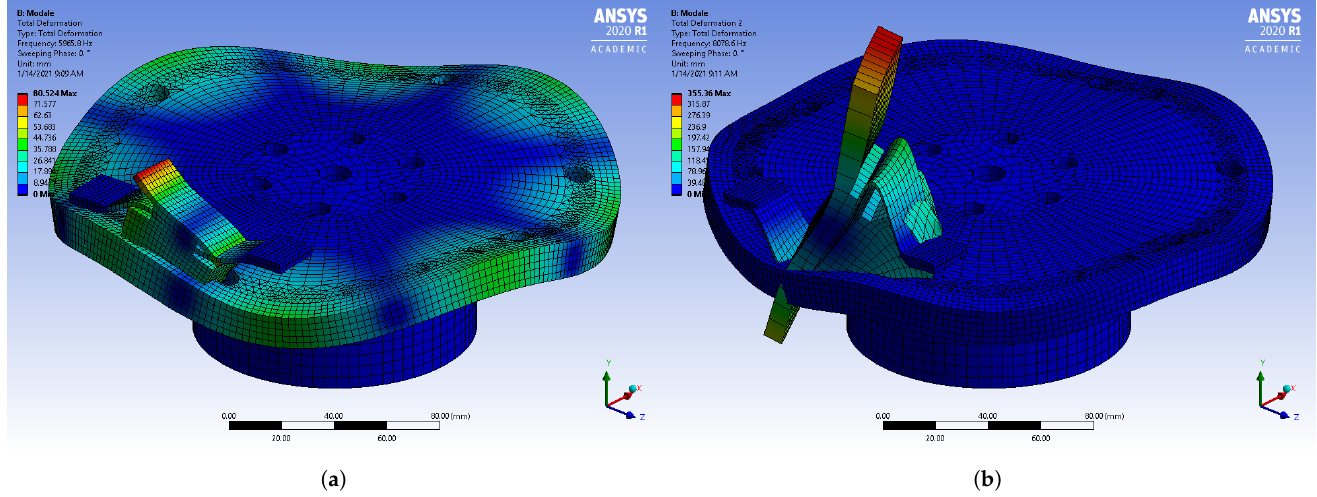
Figure 10. Calculated unstable mode shape of the system at ( a ) 5966 Hz (experimentally verified) and ( b ) 8079 Hz